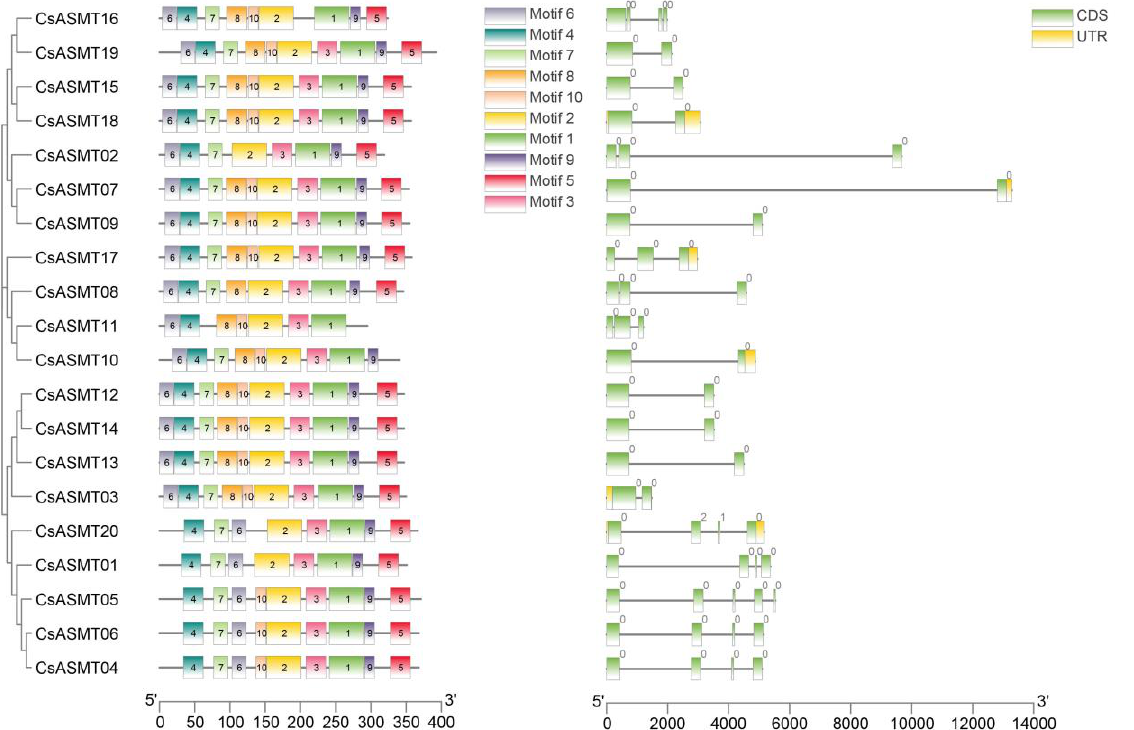
Figure 2. Conserved motifs and gene structure analysis of C. sinensis ASMT gene family. Different colored boxes with numbers on the left side represent different types of motifs. UTRs are represented by green boxes on the right side of the figure, CDS sequences are represented by yellow rectangles and introns are represented by grey lines.